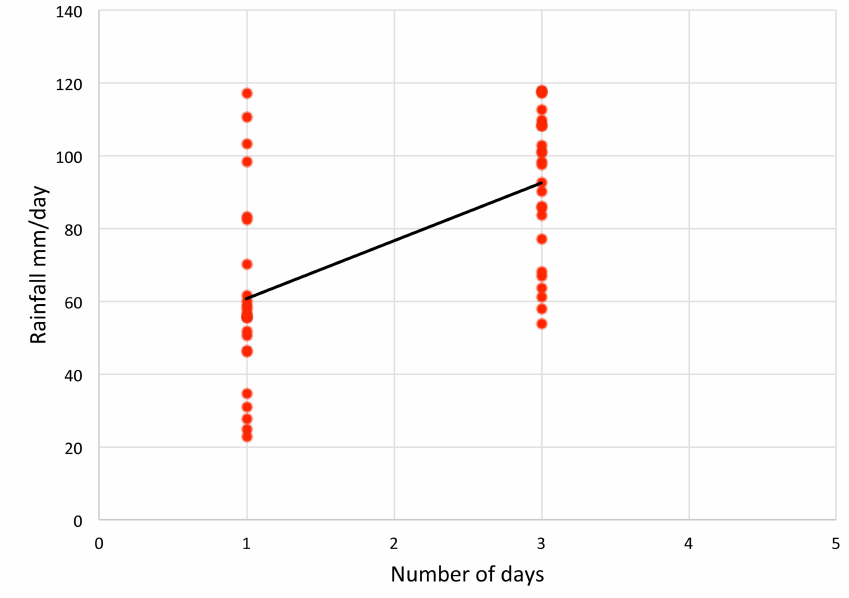
Figure 2. 1-day and 3-day cumulative precipitation data, which triggered landslides at 83 locations in Indonesia.